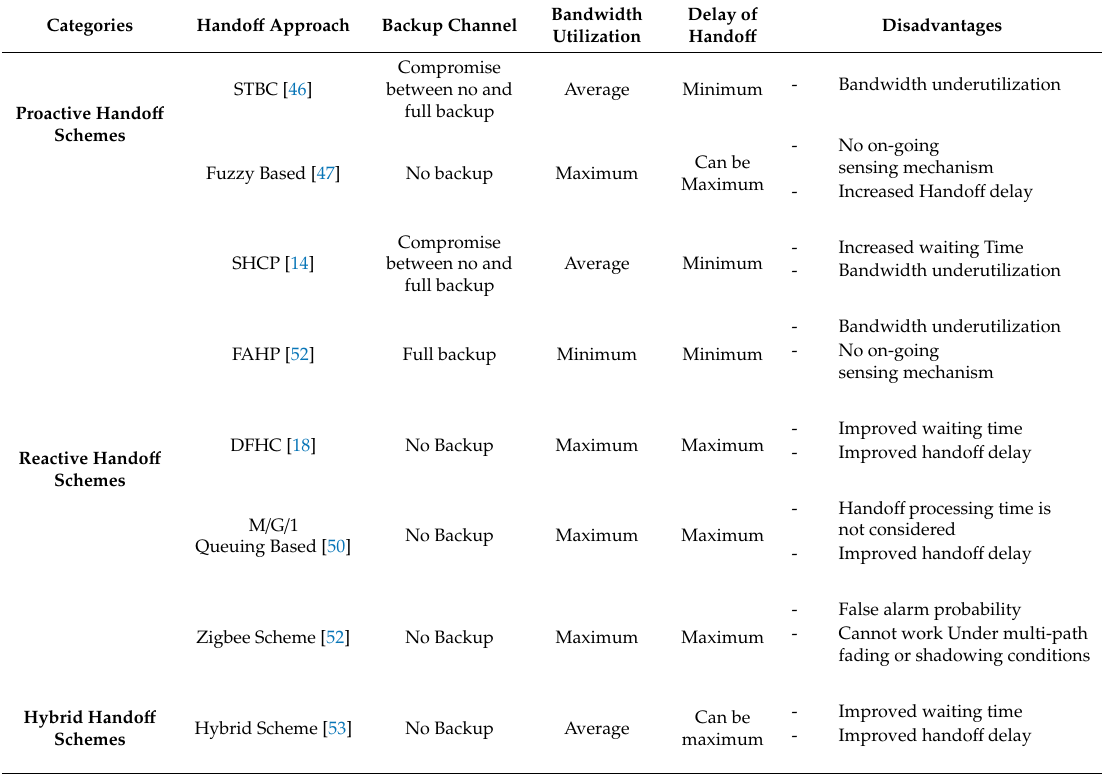
Table 1. Comparison of some of the existing hando ff strategies with regards to the channel backup, bandwidth utilization and the hando ff